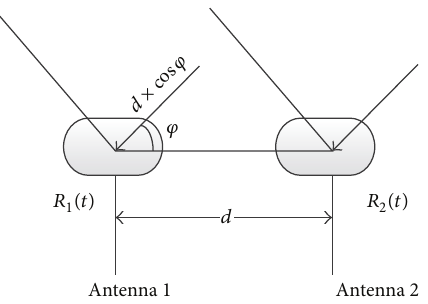
Figure 6: The position of radiation source and two flat parallel broadband antennas. Also, the assumption of having parallel radi- ated signals.